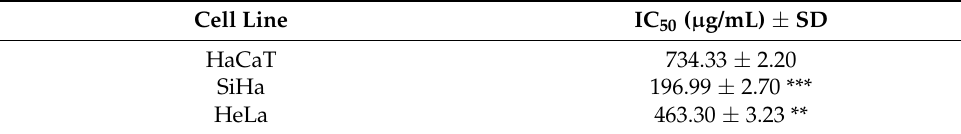
Table 3. IC 50 of Ace-EFc on the viability of HaCaT, SiHa, and HeLa cells.